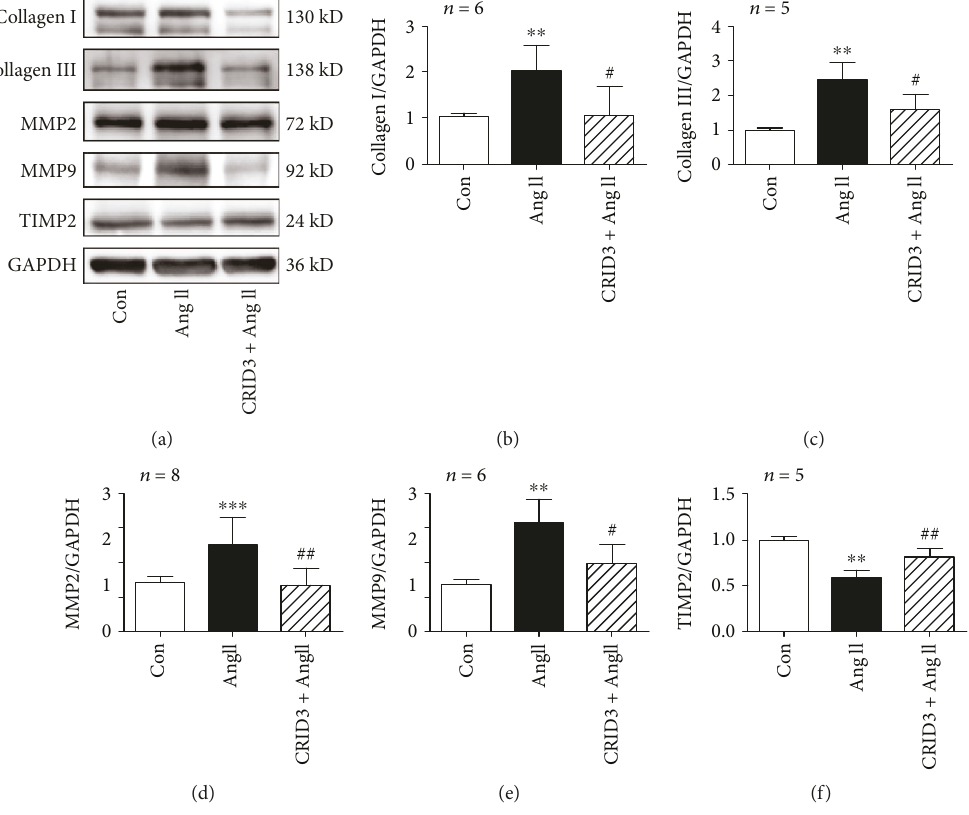
Figure 7: CRID3 inhibited collagen synthesis in VSMCs stimulated with Ang II. (a) Protein expression of collagen I, collagen III, MMP2, MMP9, and TIMP2 was detected by western blot. VSMCs were treated with CRID3 (25 μ M) for 30min before adding Ang II. ∗∗ P < 0 01 and ∗∗∗ P < 0 001 vs. control; # P < 0 05 and ## P < 0 01 vs. Ang